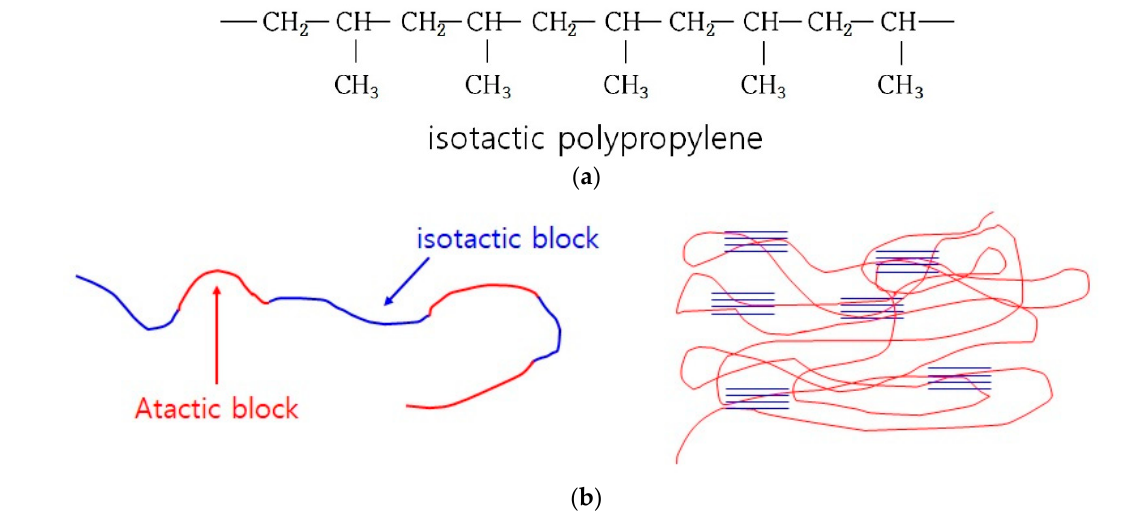
Figure 6. Schematic diagram of the combination of isotactic and atactic structures: ( a ) isotactic polypropylene structural formula; ( b ) structural formula consisting of atactic and isotactic single bonds (left), and structural formula of block copolymer in which many isotactic structures are formed and combined (right), Blue line is isostatic block, Red line is Atactic block.